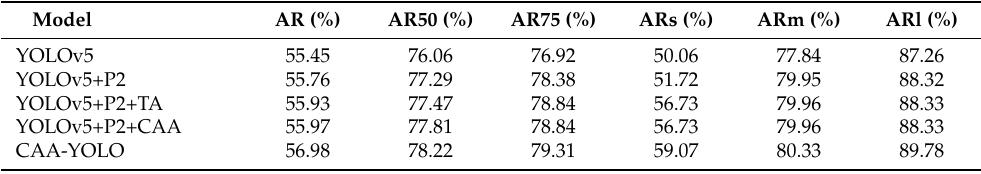
Table 7. Average recall of experimental results when IoU = 0.6 and confidence = 0.3.